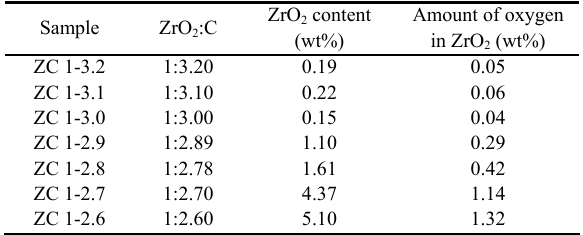
XRD phase analysis